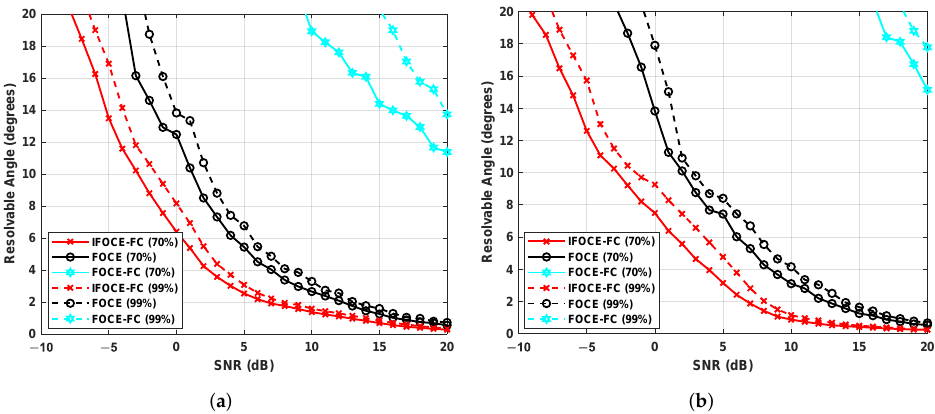
Figure 9. Comparison of different algorithms for the resolvable angle versus the SNR in the UCA application. ( a ) Resolvable elevation. ( b ) Resolvable